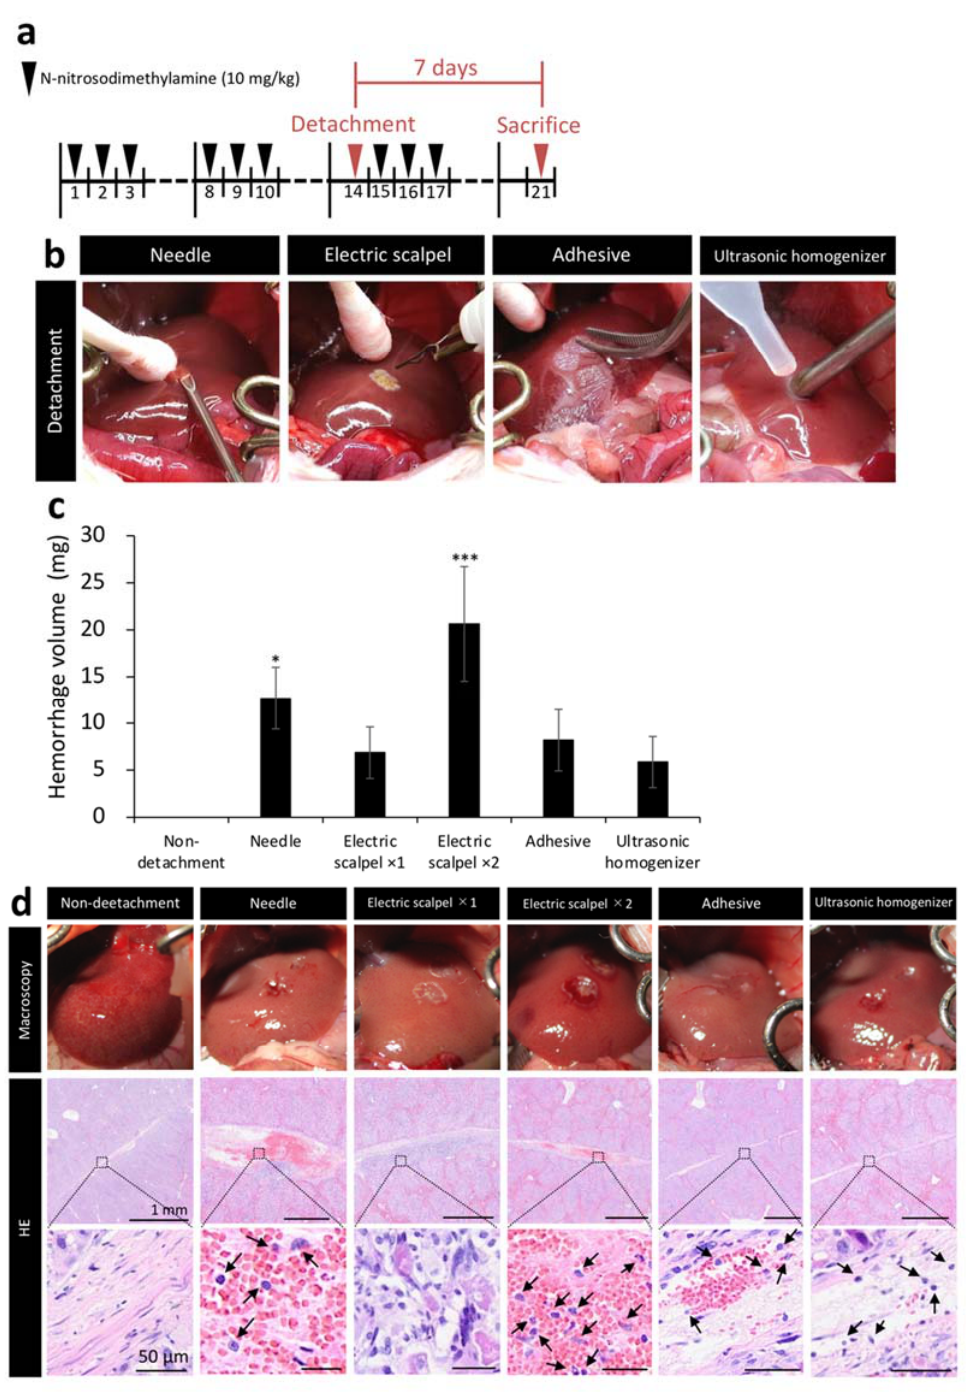
Figure 2. Assessment of tissue damage in five detachment methods. ( a ) Rat model of liver cirrhosis was produced as described in Figure 1. Livers were collected 7 days after transplantation in Figure 2. ( b ) Image showing detachment of serous membrane using the needle, electric scalpel, tissue adhesive, and ultrasonic homogenizer methods. ( c ) Bleeding amount per minute ( n = 3). ( d ) Immediately after the detachment of serous membrane of the left lobe, the livers were observed macroscopically. In addition, the livers were removed one week after the serous membrane detachment to stain the detached site with hematoxylin/eosin (HE). Arrows indicate inflammatory cells. The data are shown as the mean ± Standard error. * p < 0.05, *** p < 0.001 versus non-detachment group by non-repeated measures analysis of variance with Bonferroni correction.